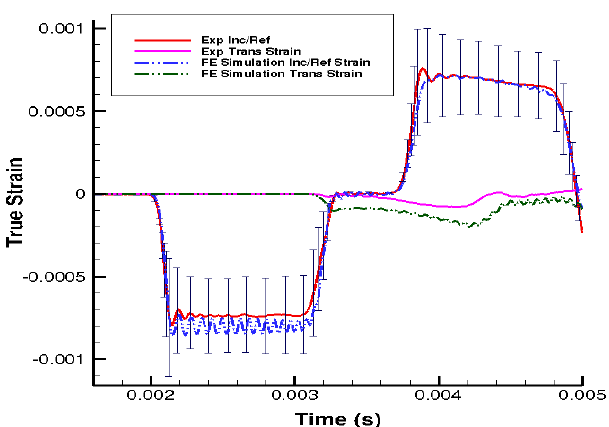
Figure 5. Comparison of the strain in the loading direction from the experimental data and finite element (FE) simulation results at 550 s − 1.